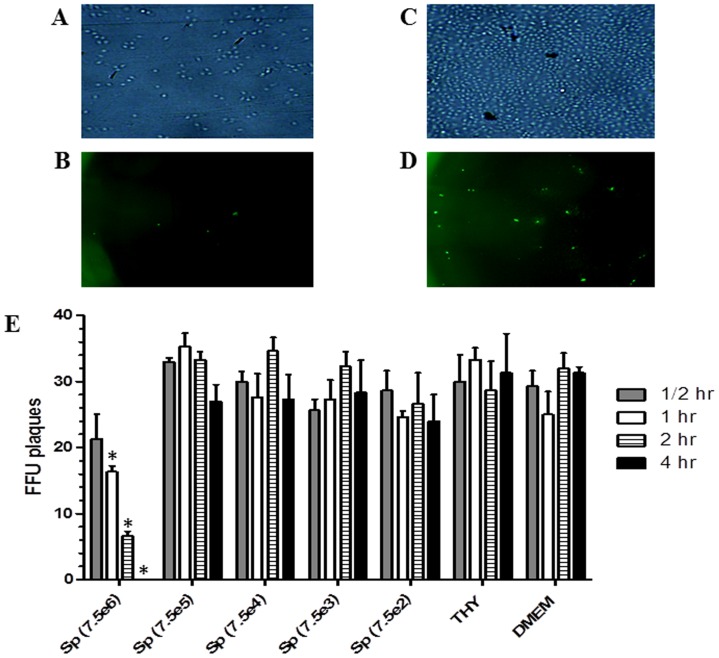
Effect of a range of S. pneumoniae inoculums on IAV replication.A representative study with MDCK cells pretreated with live S. pneumoniae (TIGR4) for 1 hr followed by infection with an IAV strain (SwH1N1/OH/2007/43266) for 20 hr. Infected cells were analyzed by both light microscopy and immunofluorescence microscopy: (A and C) cells pretreated with 7.5×106 and 7.5×105 CFUs of live TIGR4 strain, respectively, and analyzed by light microscopy; (B and D) similarly treated cells but immunostained and analyzed by immunofluorescence microscopy using a FITC filter. (E) MDCK cells were pretreated with five 10-fold dilutions (7.5×106 to 7.5×102) of live S. pneumoniae (TIGR4) for four time points (0.5–4 hr) and the effect on replication of IAV was assessed by IFA. Each bar represents the average FFU in triplicate wells ± SEM. An asterisk indicates a statistically significant (p<0.05) difference between FFU observed following pretreatment with THY medium and S. pneumoniae cultures for the stated time period.